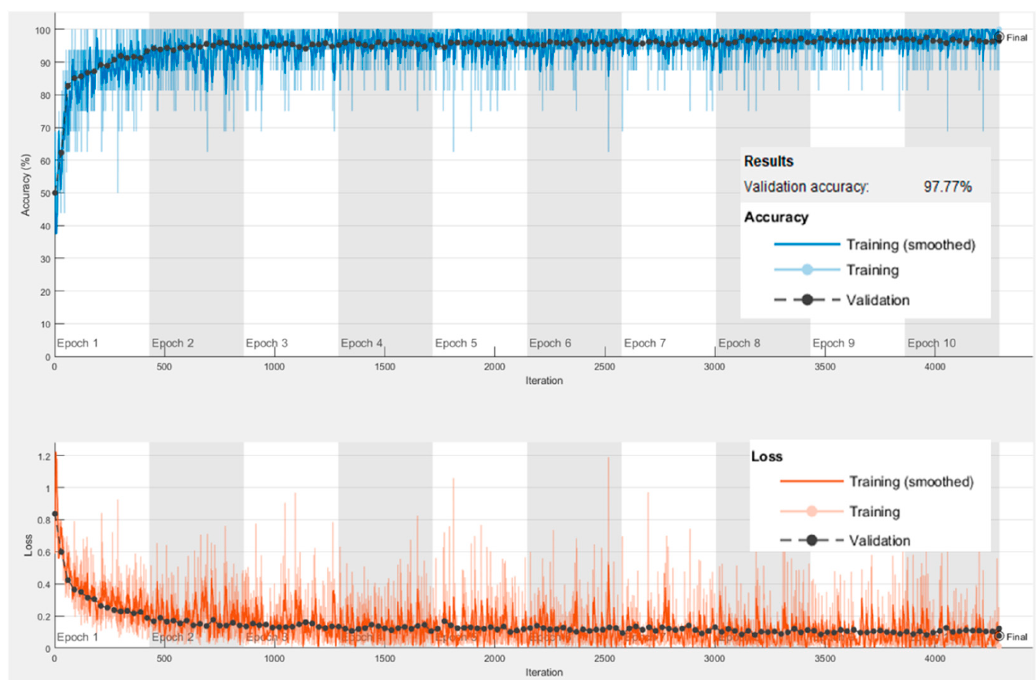
Figure 5. Training and Validation accuracy of the proposed CB-STM-RENet technique on the CoV-NonCoV-15k dataset.